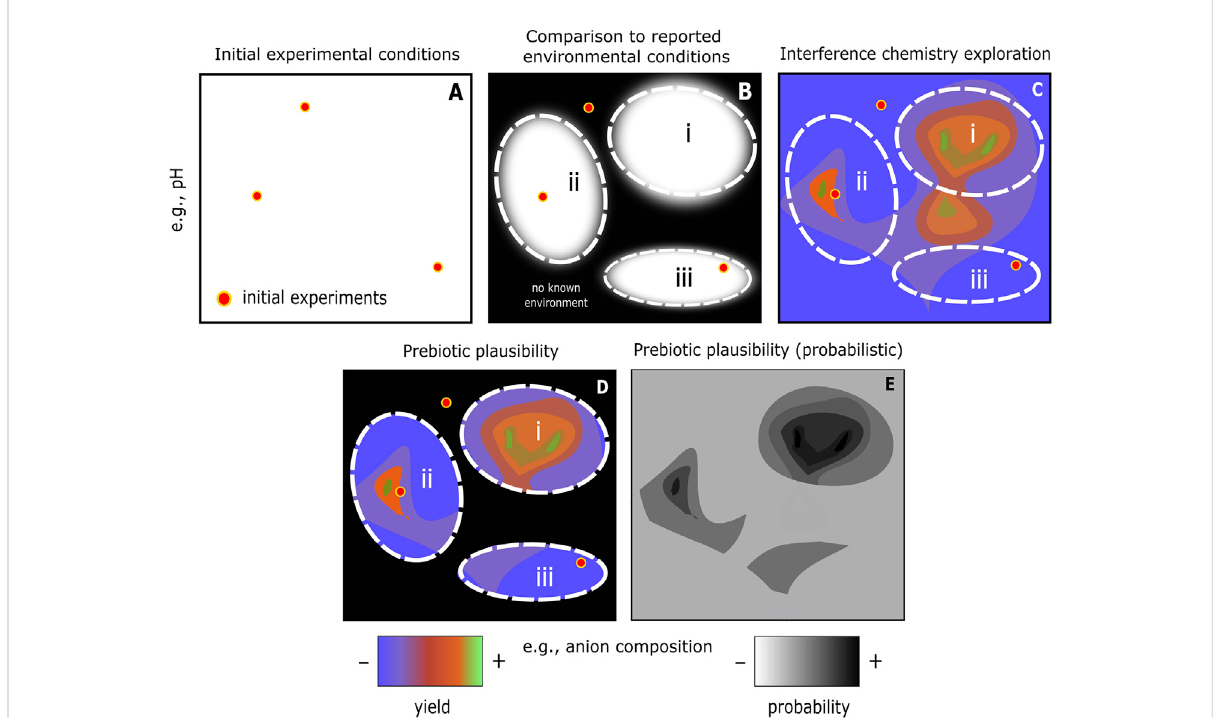
FIGURE 3 Schematic example of interference chemistry work fl ow to determine prebiotic plausibility. (A) Initial experimental conditions for a proposed prebioticreactionsteporsystemthathasbeenconsideredsuccessful. (B) Reportedrangeofconditionsforvarioustypesofenvironment(i,ii,andiii). Outside of the reported range may be considered prebiotically implausible in a strict sense, but this should never be considered fi nal given the ever- improving geoscienti fi c knowledge base. (C) Results from interference chemistry exploration of the reaction/system under consideration. Some experimental initial conditions emerge as being close to the local maximum scenario, e.g., in the parameter space encompassed by environment ii. In other cases, signi fi cant yield improvement is observed by traversing parameter space, e.g., traversing the conditions that occur in environmenti.Moreinformation mightbegainedbyevaluatingthedeltayieldthatresultsfromapplyingnumerousinterferences,i.e.,approximating more closely the messy environments that occur in nature. (D) The combination of experimental, environmental, and interference chemistry constraints yields one way to quantify prebiotic plausibility for any given scenario — subject to propagated chemical/geological uncertainties. (E) Prebiotic plausibility could be further formalised in terms of probability. In our case, this would be in terms of yield: the product of probability that an environmental condition may occur, combined with the yield at those